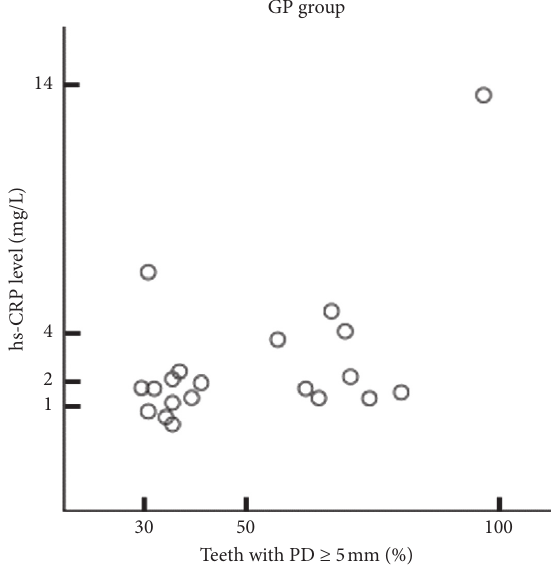
Figure 4: Matrix scatter plot of the proportion of teeth with ≥ 5mm PD and CRP concentration in the CPG group. The proportion of teeth with ≥ 5mm PD was significantly associated with CRP concentration in the CPG group.